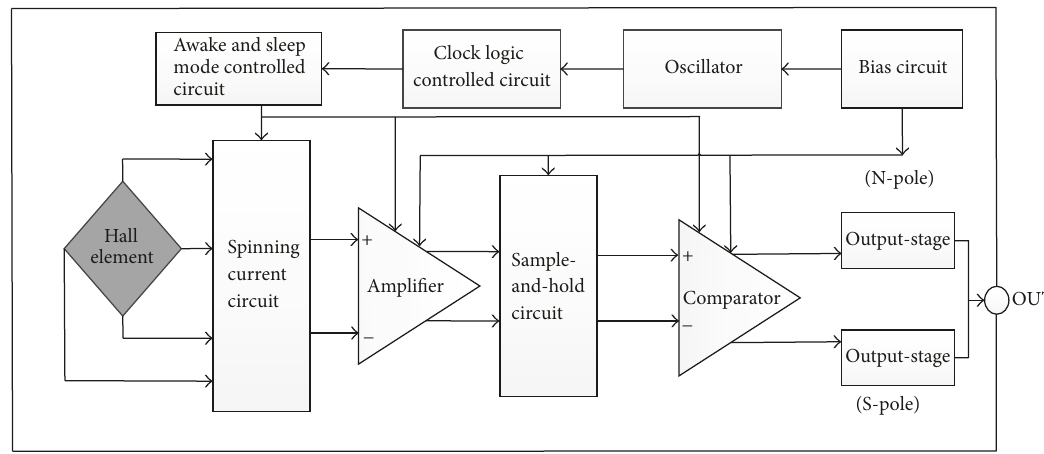
Figure 7: Circuit structure of the Hall switch